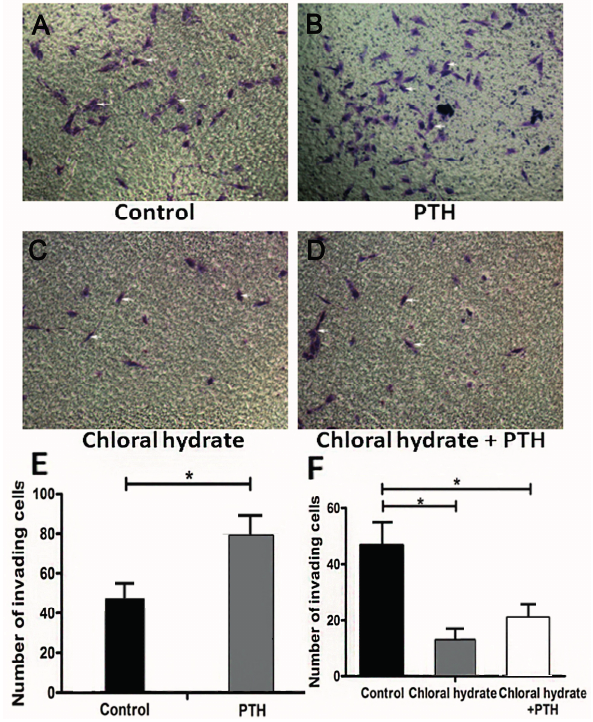
Figure 3. PTH enhances chondrosarcoma cells’capacity for invasion by interacting with primary cilia. The white arrows refer to tumor cells. Image A is the control group; Image B shows PTH stimulation on tumor cell invasion ability; Image C shows the effect that chloral hydrate stimulation on tumor cell invasion; Image D shows the influence that PTH caused after stimulating tumor cell on chloral hydrate; These histograms ( E and F ) display the average number of invading cell on different conditions. ( * p <